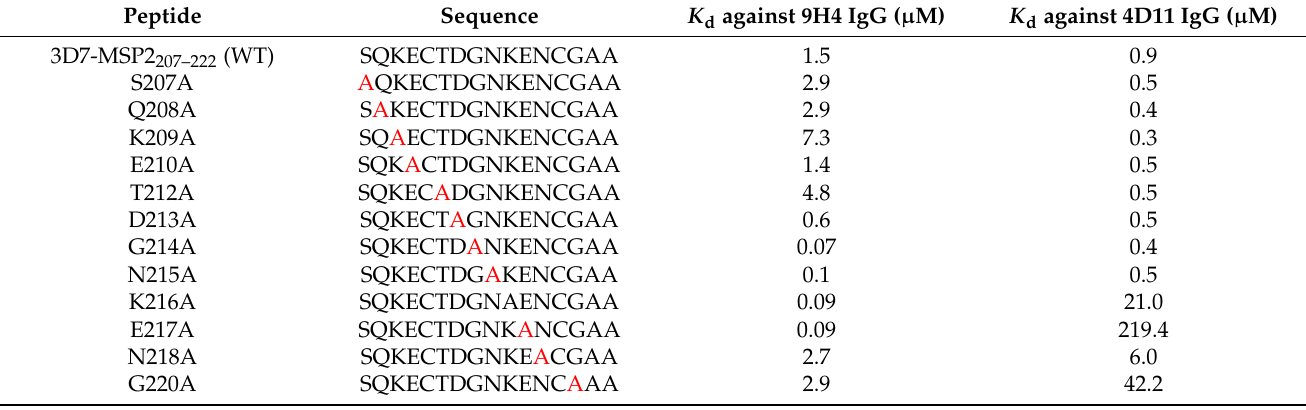
Table 1. Alanine scan of 16-residue epitope MSP2 207–222 to determine key residues for binding of mAbs 9H4 and 4D11. The Ala residue is highlighted in